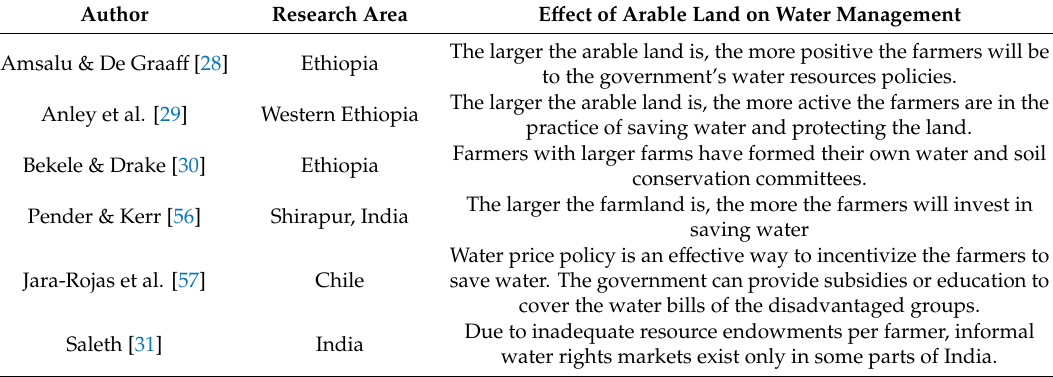
Table 4. Previous studies of